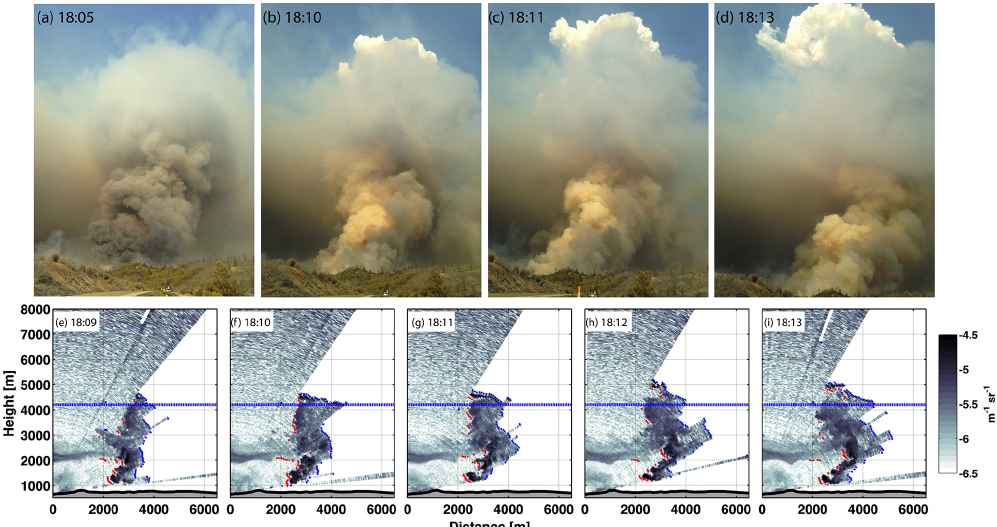
Figure 13. Pyrocumulus development from 18:05–18:13PDT on 30 July 2015. (a–d) Photographs of the plume rise and pyroCu development. (e–i) Lidar backscatter showing the onset of condensation and subsequent cloud growth. The dashed blue lines shows the lidar-derived condensation